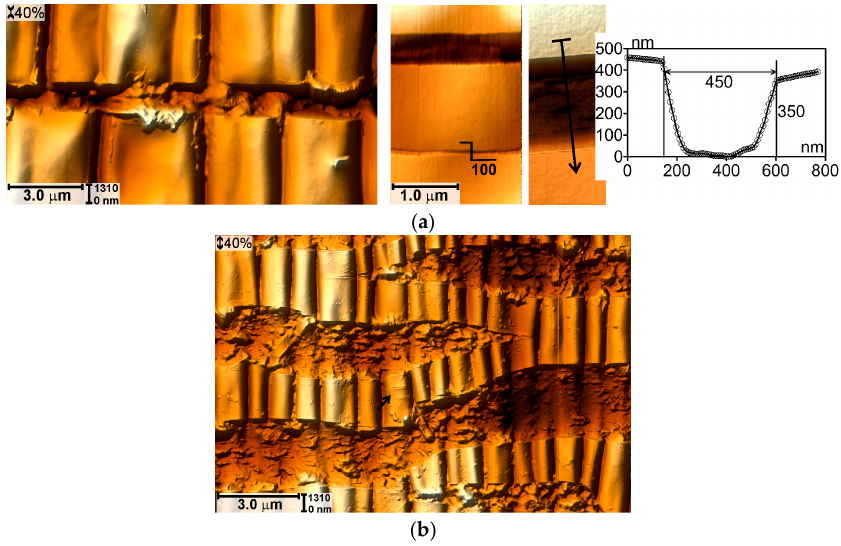
Figure 9. AFM images of PU after the PIII 3-17 and fatigue loading to 40% in the unloaded ( a ) and stretched ( b ) states. In ( a ) the height of crack step is shown (in nm). Crack of submicron size appeared on the folded layer is marked in ( b ).